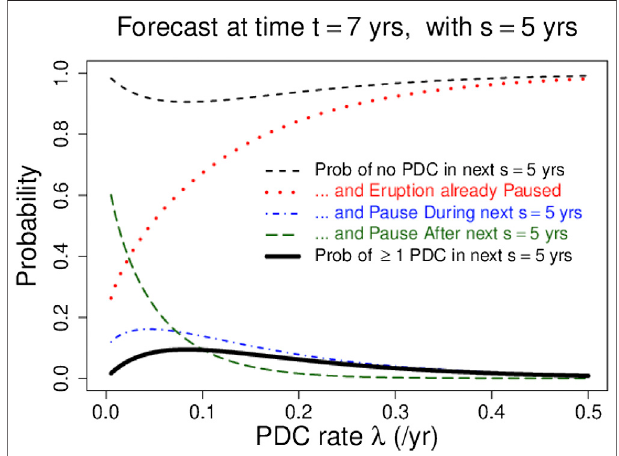
FIGURE 4 | Solid black curve shows forecast probability of at least one PDC in s (cid:2) 5 years, starting t (cid:2) 7 years after the most recent eruption and assuming an activity rate of λ events per year (on average) until the uncertain time T whenthe eruptionends, plotted for0 ≤ λ ≤ 0 . 5. Peakprobabilityof P (cid:2) 0 . 0947isachieved at λ (cid:2) 0 . 085,about oneeventper decade. Results are similar for other choices of s in the range 0 ≤ s ≤ 20 years. Other curves have same meaning as in Figure 3 .